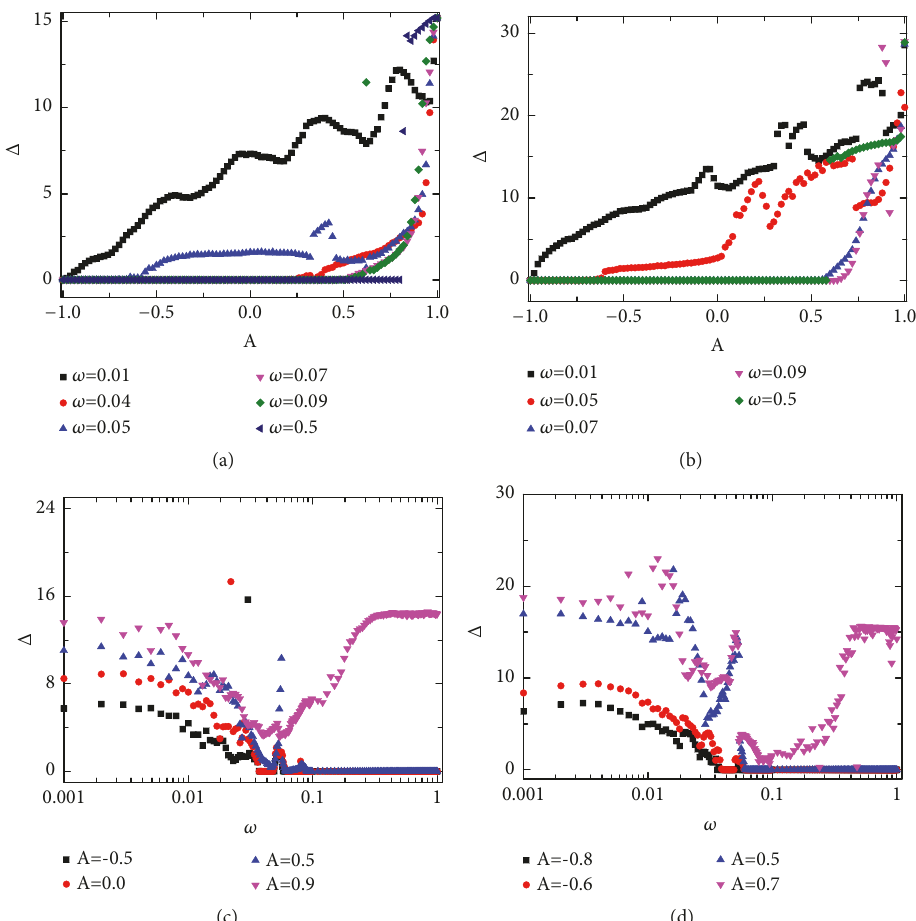
Figure 2: The synchronization error Δ against 𝐴 for different 𝜔 in (a) and (b) and against 𝜔 for different 𝐴 in (c) and (d). 𝜀 1 = 5 and 𝜀 2 = 4 in (a) and (c); 𝜀 1 = 5 and 𝜀 2 = 5 in (b) and (d).